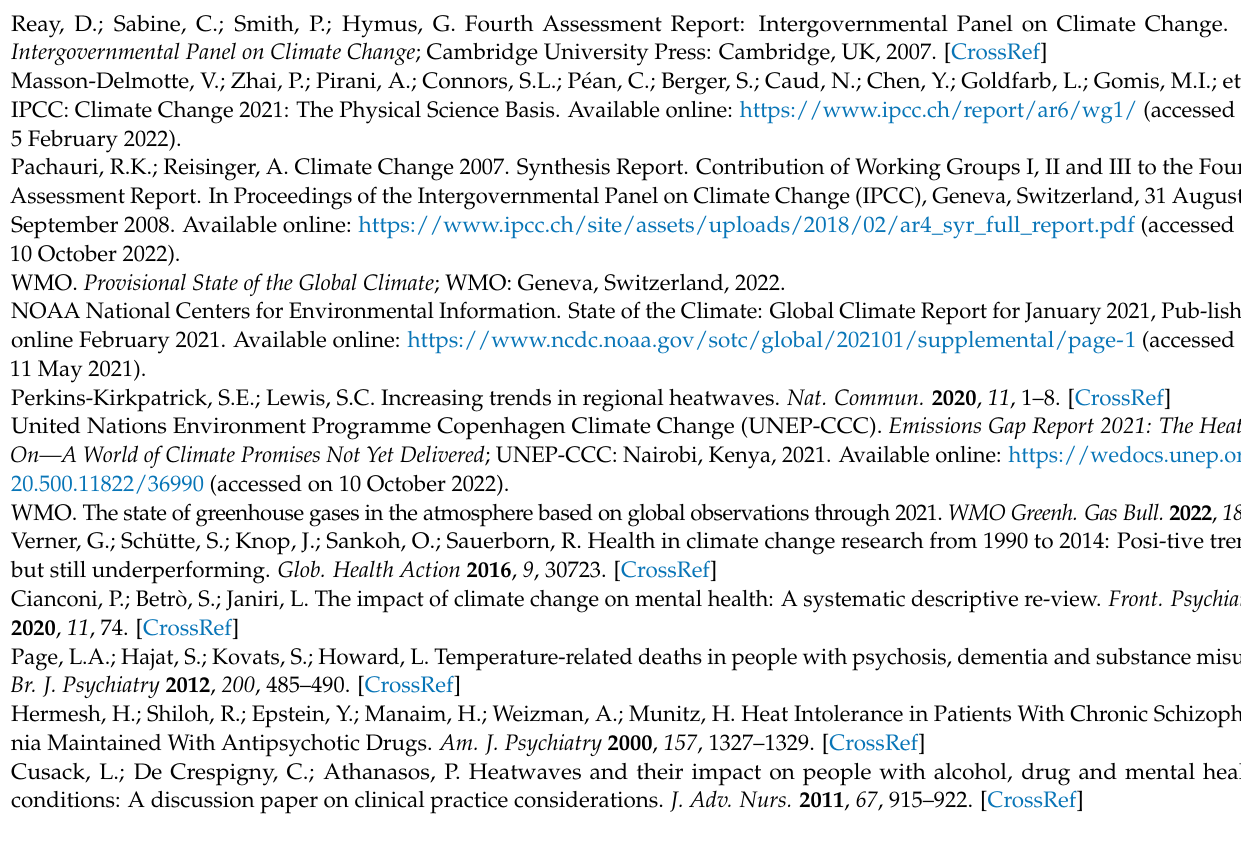
Figure S2. International Classification of Diseases 10th revision (ICD-10) with detailed information from the subgroup of the psychiatric chapter. Source; Figure S3. With the detailed information from the 105 retrieved studies; Table S3. Quality Assessment Tool for Observational Cohort and Cross-Sectional